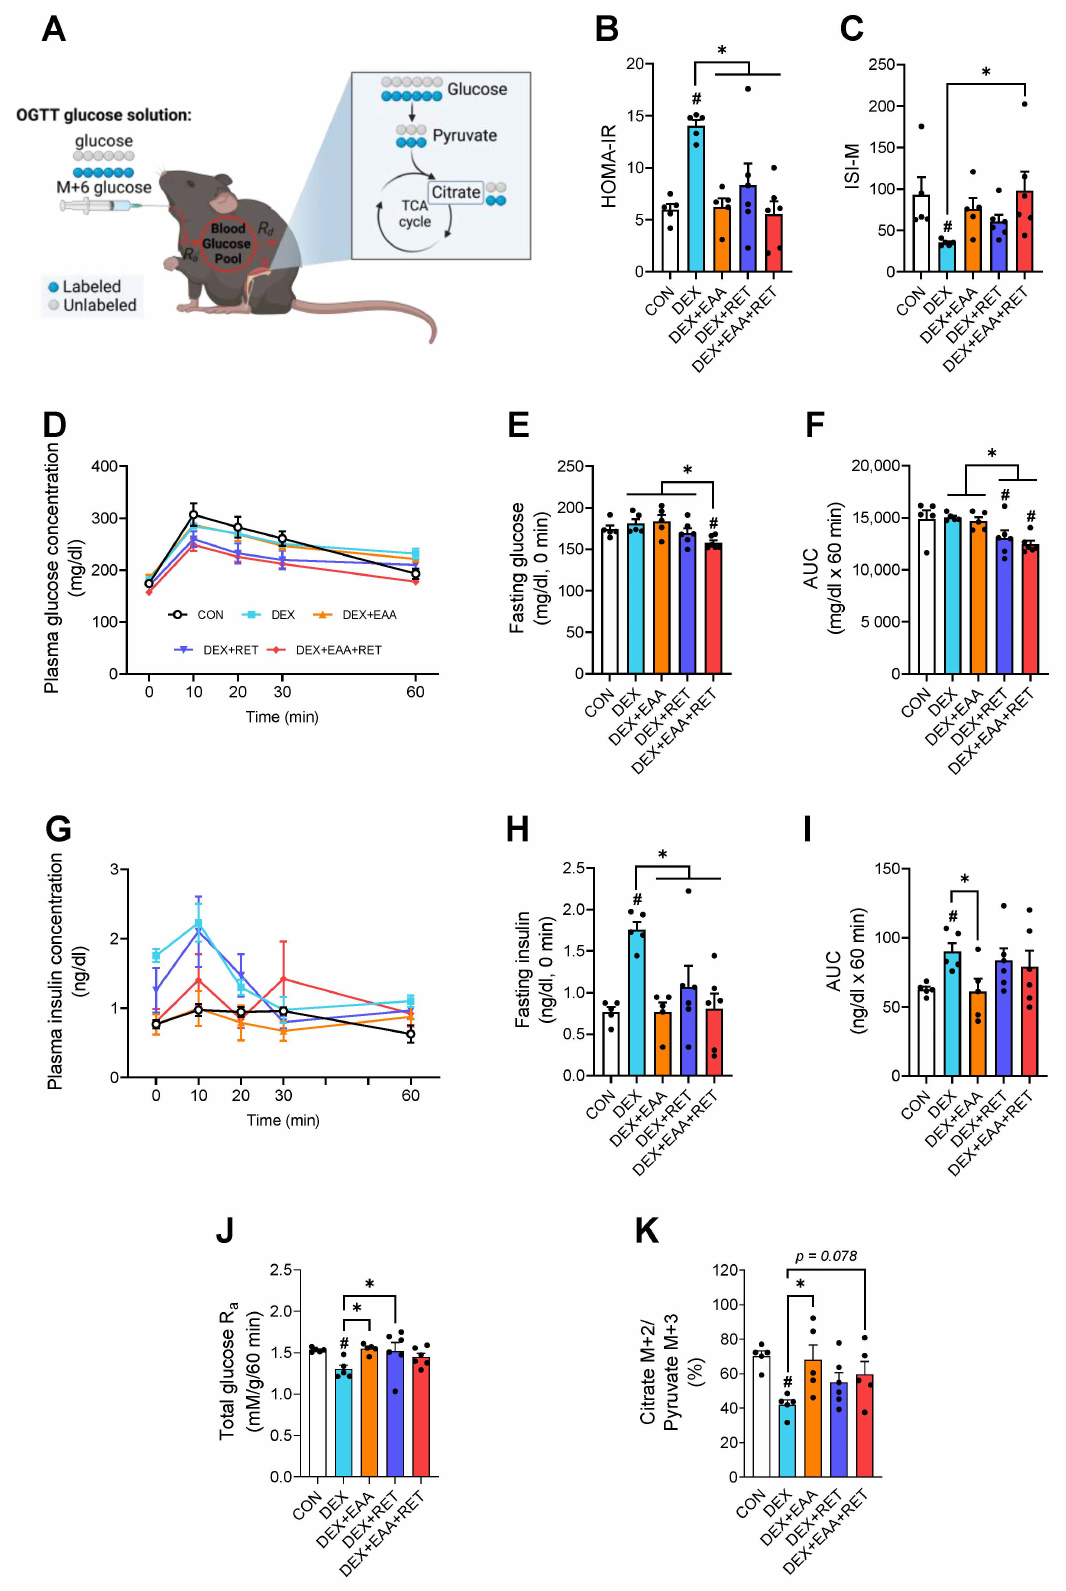
Figure 6. Combined treatment of EAA and RET completely restores impaired insulin sensitivity by DEX treatment. ( A ) Schematic showing glucose flux in vivo at systemic and myocellular levels using U- 13 C 6 glucose tracer during OGTT. This figure was created with BioRender.com. ( B ) HOMA-IR